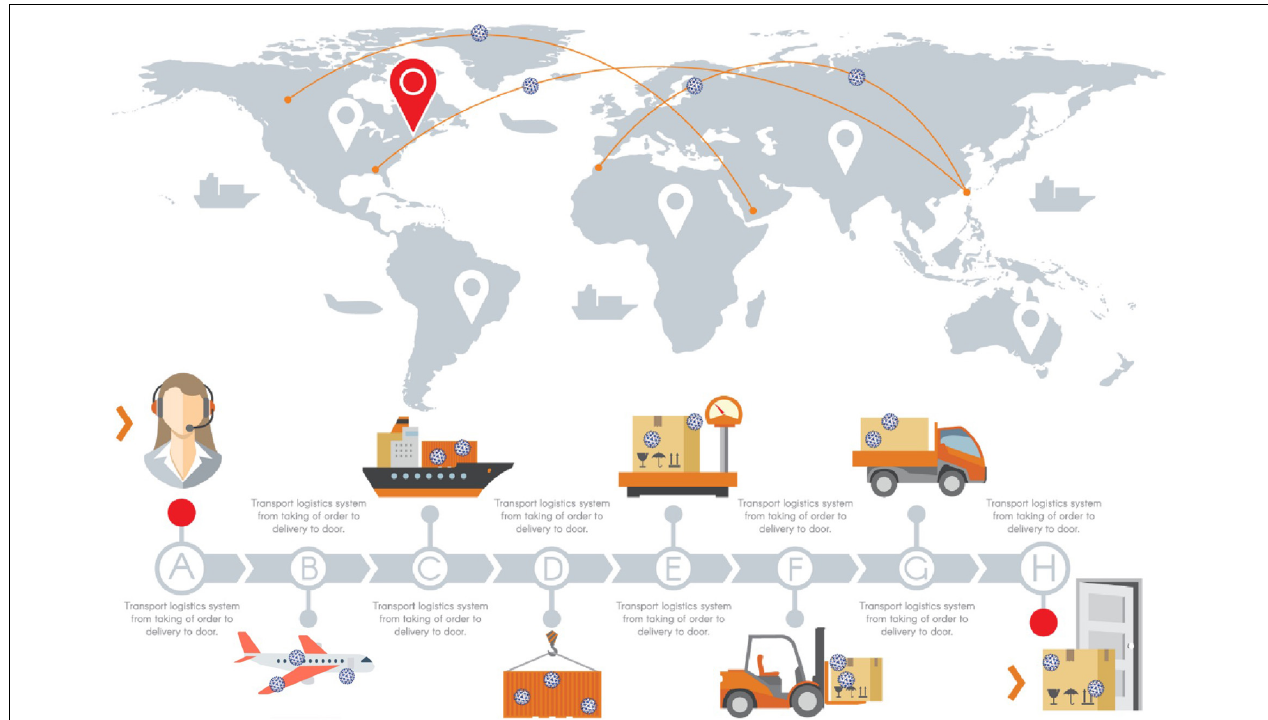
FIGURE 1 | | SARS-CoV-2 spreads globally through cross-border